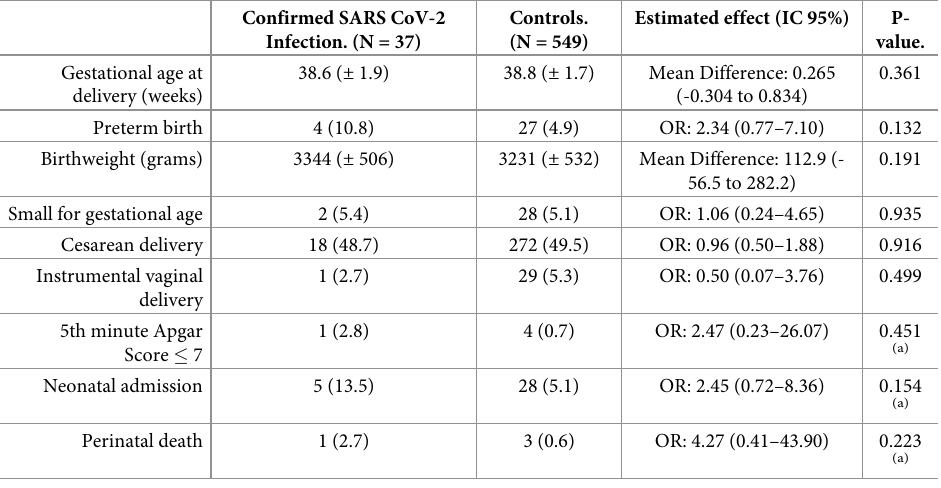
Table 3. Main perinatal